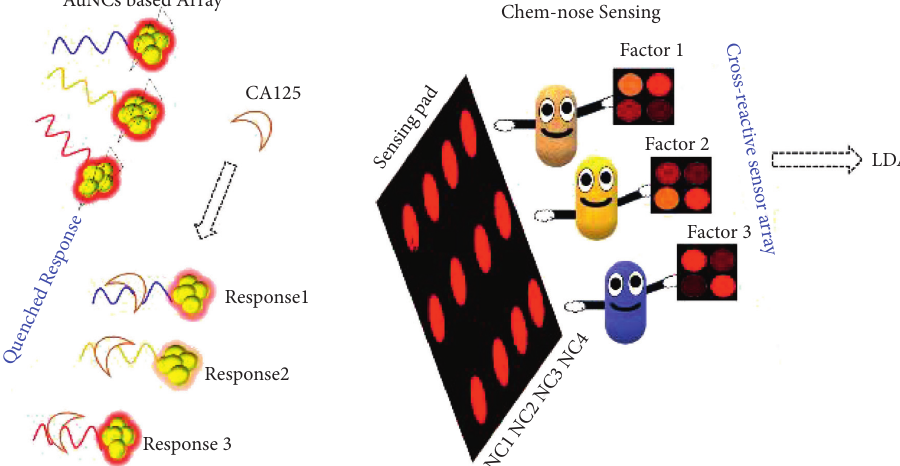
Figure 1: Quenching of the aptamer functionalized AuNCs to different extents and the array-based sensing system for the detection of CA125. Table 1: Aptamers for constructing the array-based sensing system. Aptamer